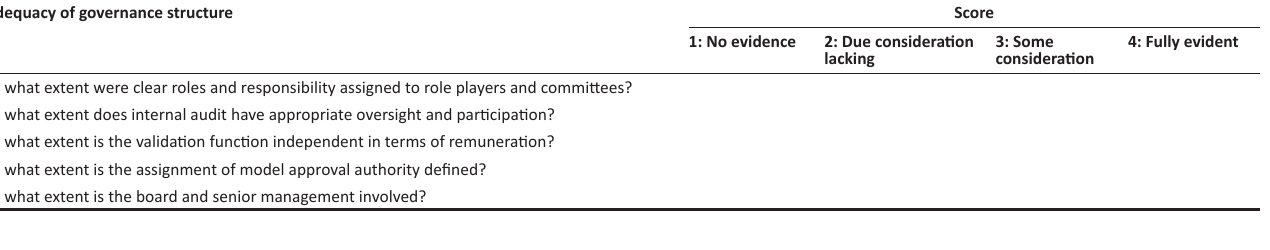
TABLE 2-A2: Model validation policy scorecard.